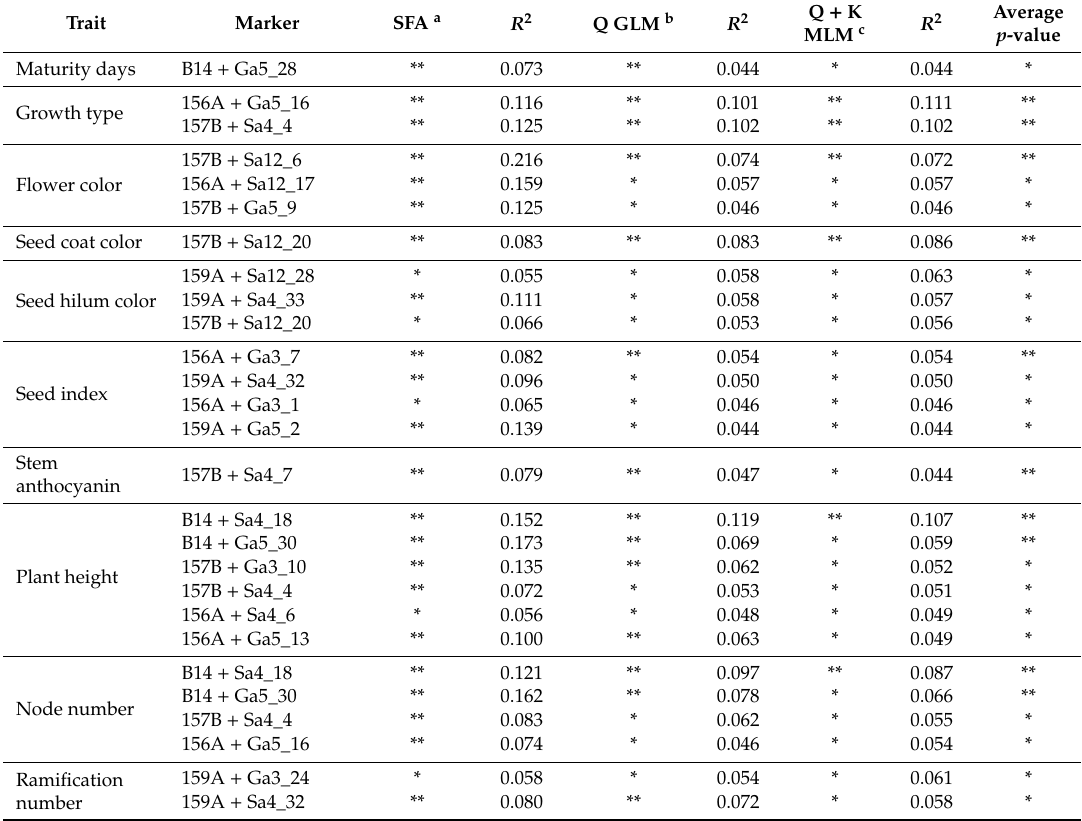
Table 6. Selection of 27 significant marker–trait associations (SMTA) markers based on three association analysis